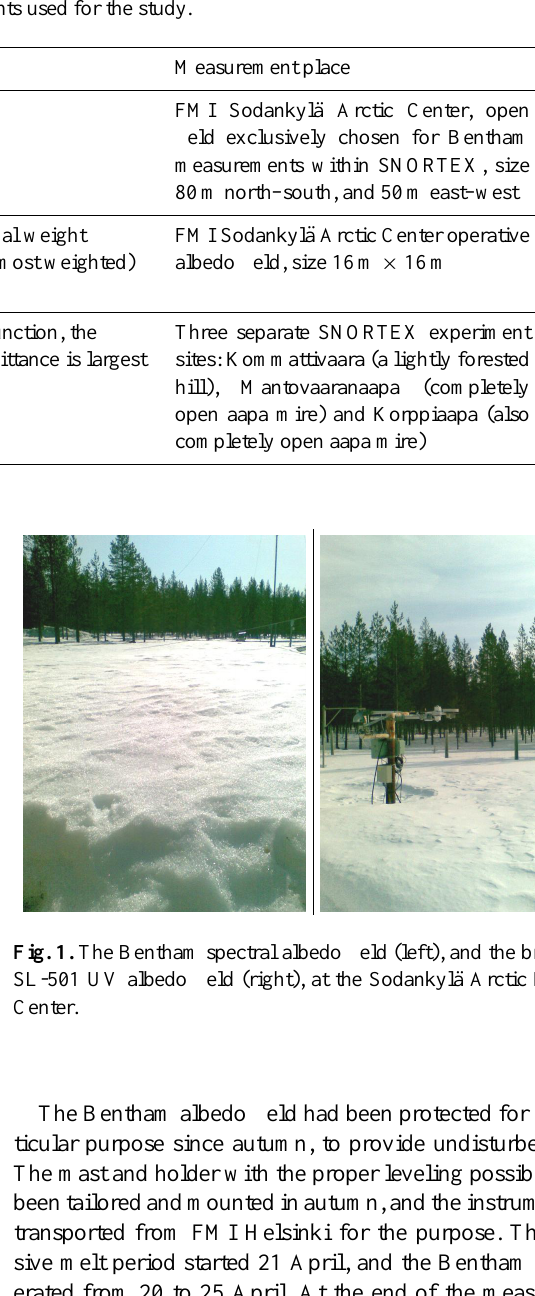
Table 1. The hemispherical spectral and broadband albedo measurements used for the study.